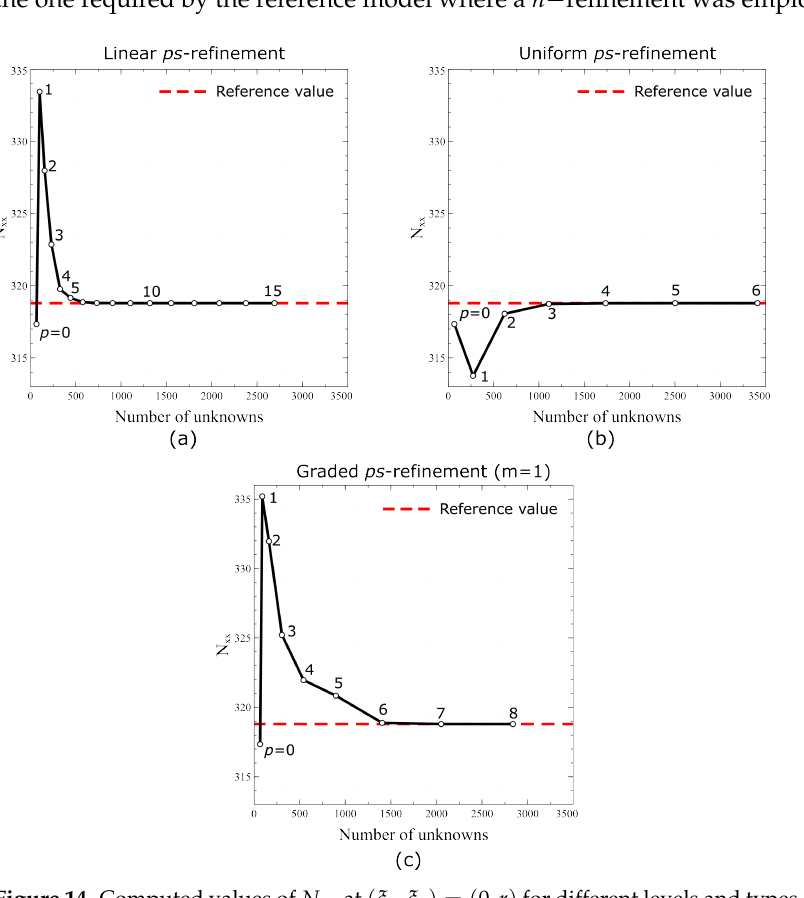
Figure 14. Computed values of N xx at ( ξ 1 , ξ 2 ) = ( 0, r ) for different levels and types of ps − refinement: ( a ) linear, ( b ) uniform, and ( c )